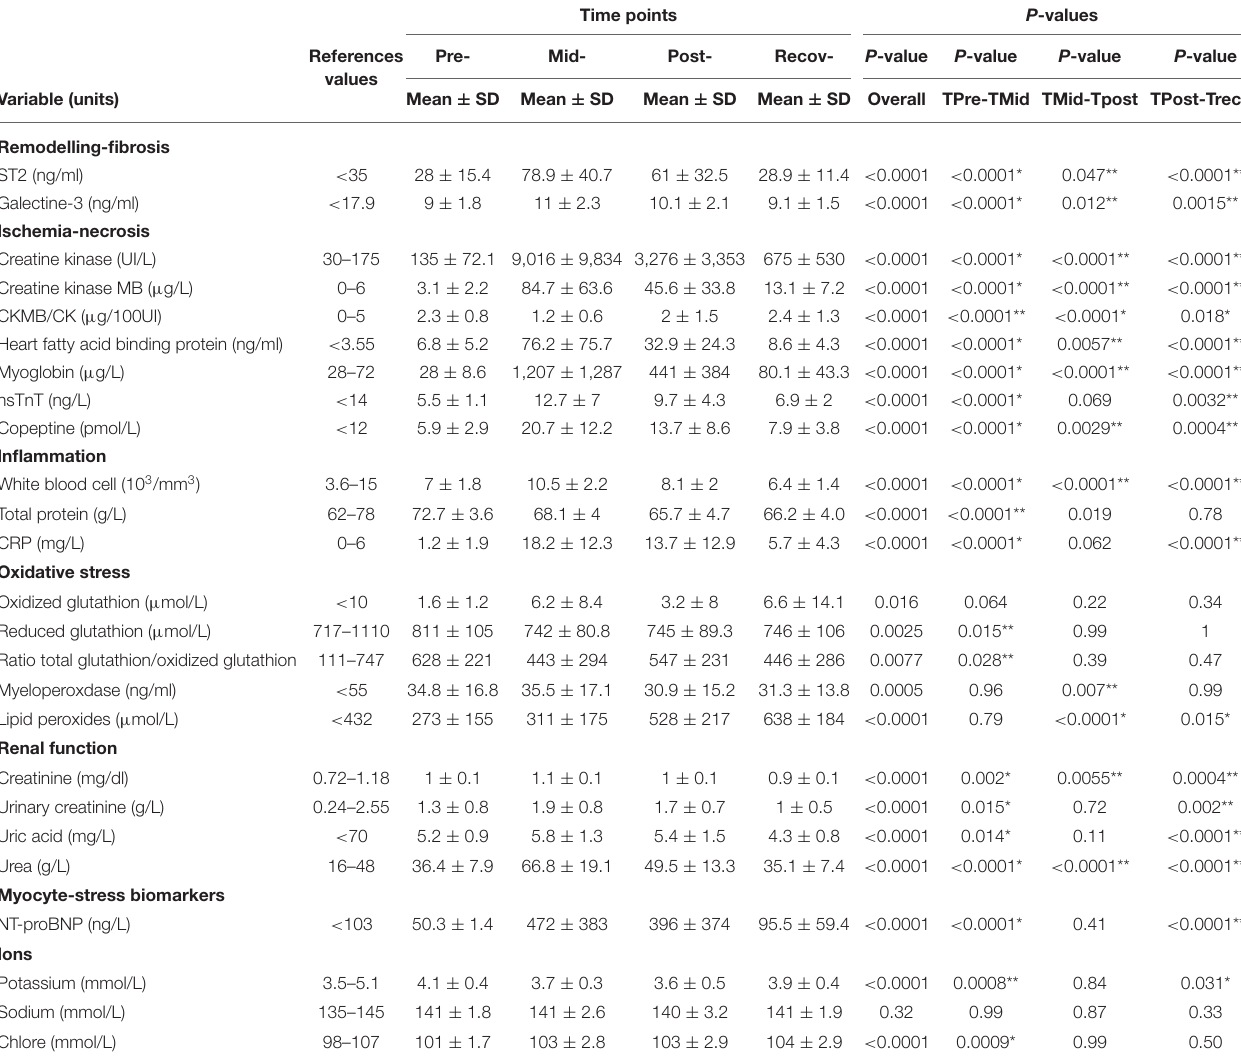
TABLE 2 | Blood biomarker concentrations (mean ± SD) at different time points and the p -value in the Tors de Geants (TDG) runners. Time points P